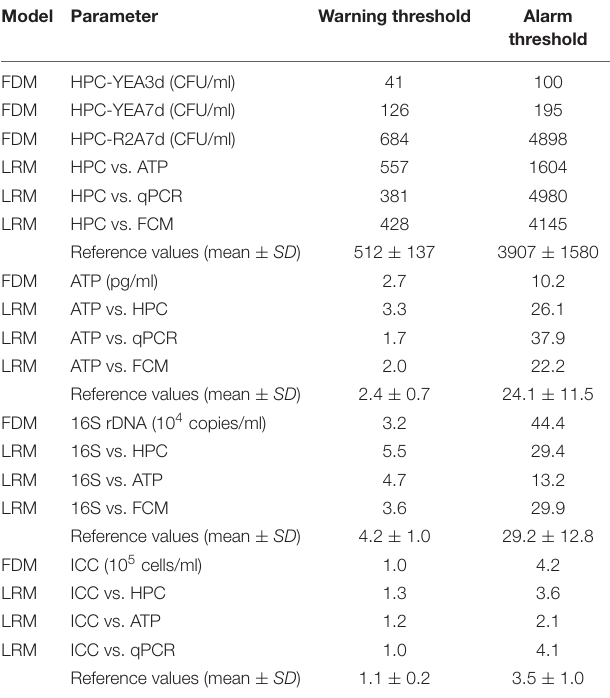
TABLE 1 | Warning and alarm thresholds, computed according to the frequency distribution model (FDM) of each single parameter (see also Figures 1 , 2 ) and the correlation equations of Linear Regression Model (LRM) between pairs of